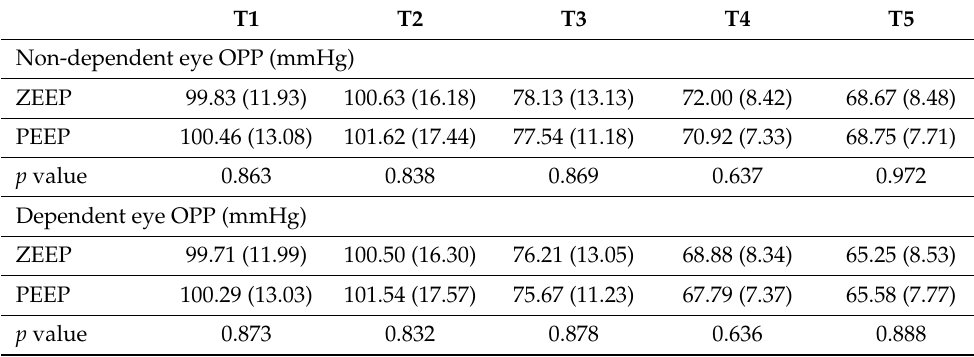
Table 4. Comparisons of ocular perfusion pressure (OPP)